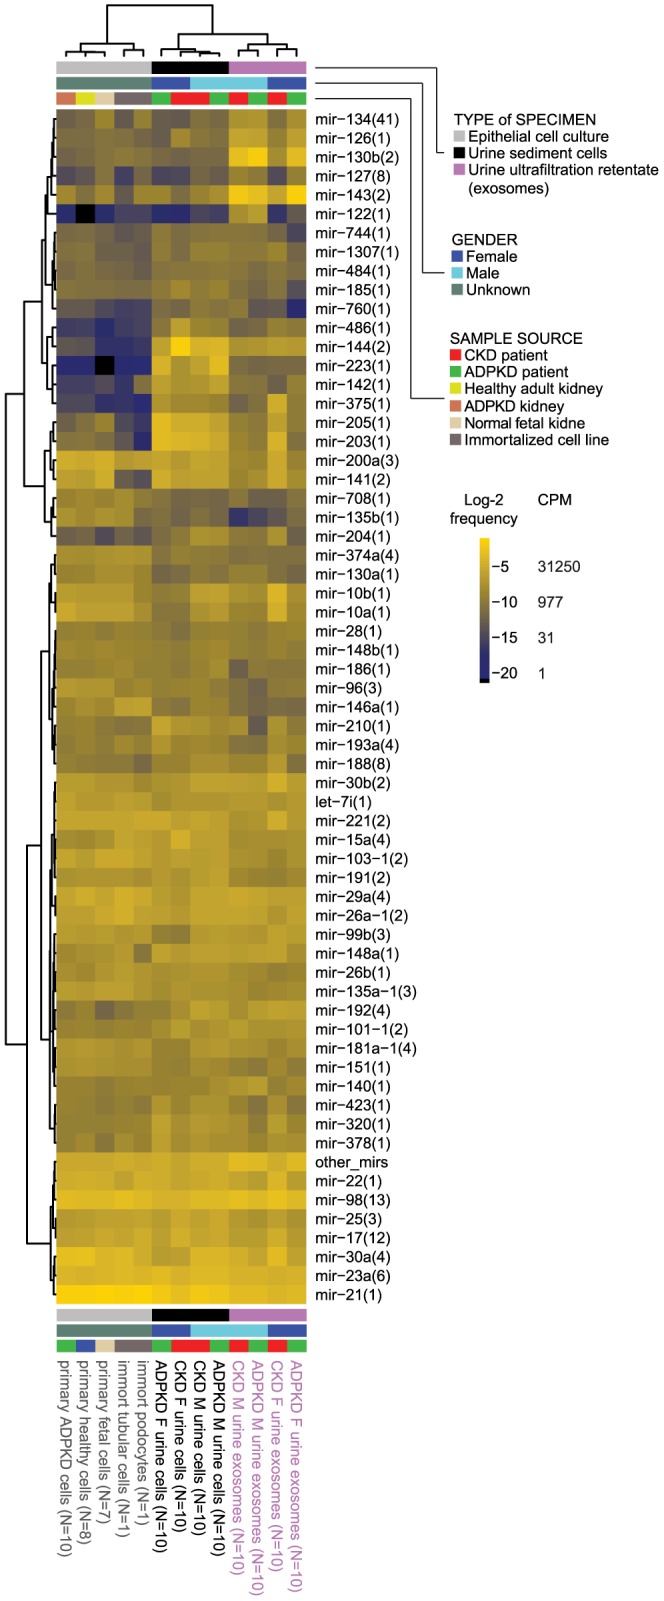
Hierarchically clustered study samples grouped by type and clinical characteristics.including additional non-study specimens for reference (columns) and miRNA cistrons (rows). High relative read frequency (log2-transformed) is indicated by bright yellow shades; low frequencies in dark blue. Corresponding numerical data is presented in the supplementary tables. Abbreviations: ADPKD, autosomal dominant polycystic kidney disease; CKD, chronic kidney disease; immort, immortalized; CPM, counts per million; F, female; M, male.